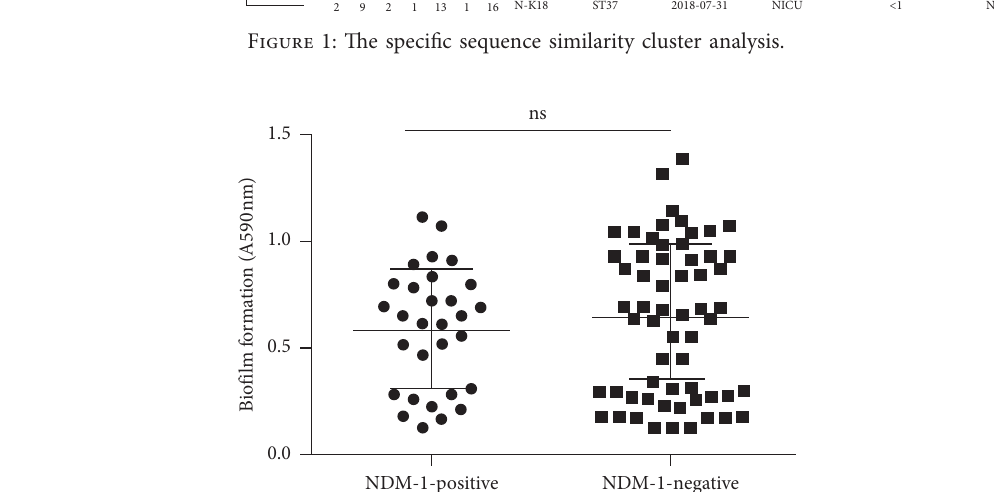
Figure 2: The biofilm formation. Note. The circles indicate the 30 NDM-1-positive K. pneumoniae ; the squares indicate the 60 NDM-1- negative K. pneumoniae